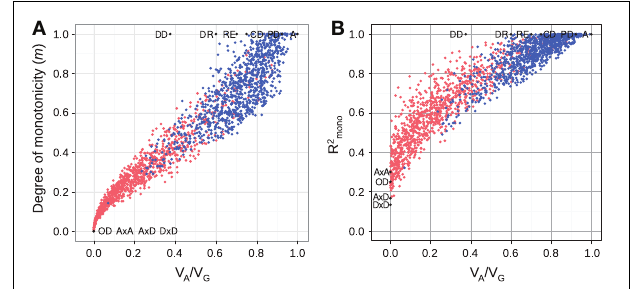
FIGURE 3 | Measures of monotonicity vs. additivity of GP maps. Scatterplots showing V A / V G from unweighted regression vs. (A) degree of monotonicity ( m ) and (B) R 2 mono from isotonic regression. Black dots correspond to the maps shown in Figure 1 together with additive-by-dominance epistasis (A × D), a map with two loci showing complete dominance (CD) and two classical epistasis types from Table 1 in Phillips (1998); duplicate recessive genes (DR) and recessive epistasis (RE). Red dots show 1000 random two-locus GP maps, while blue dots show the same 1000 GP maps after rearranging genotypic values to introduce order-preservation for 1 locus [see Model and Methods in Gjuvsland et al. (2011)].